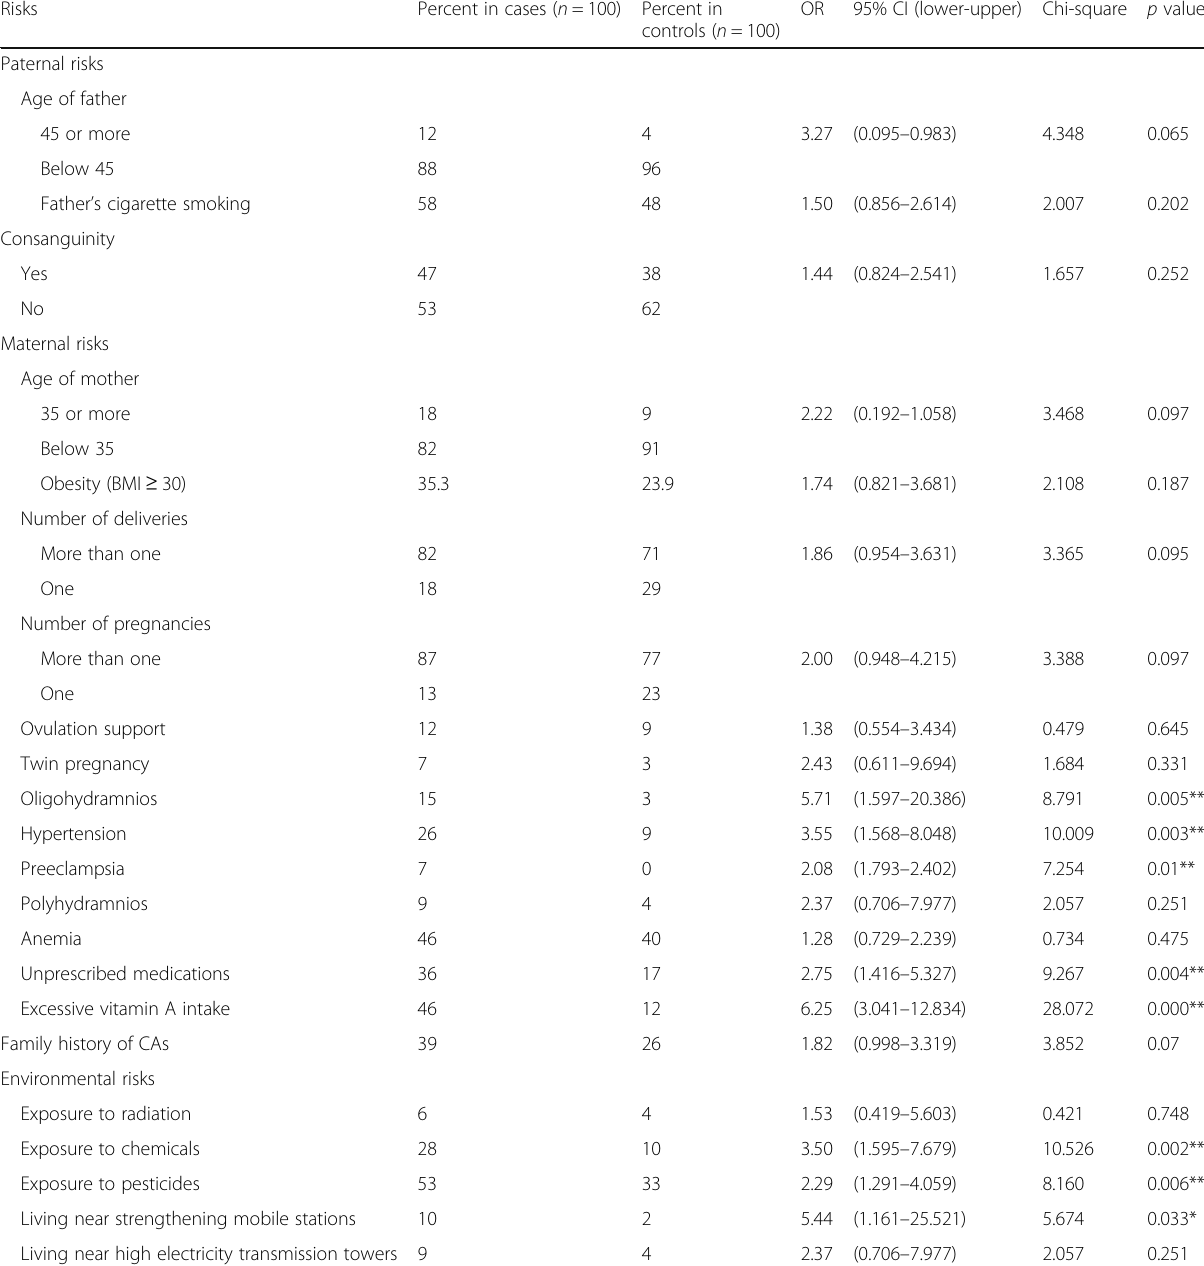
Table 4 Exposure to risks among the studied cases of CAs and their controls in the Pediatric University Hospital, Alexandria, Egypt, October 2015 – May